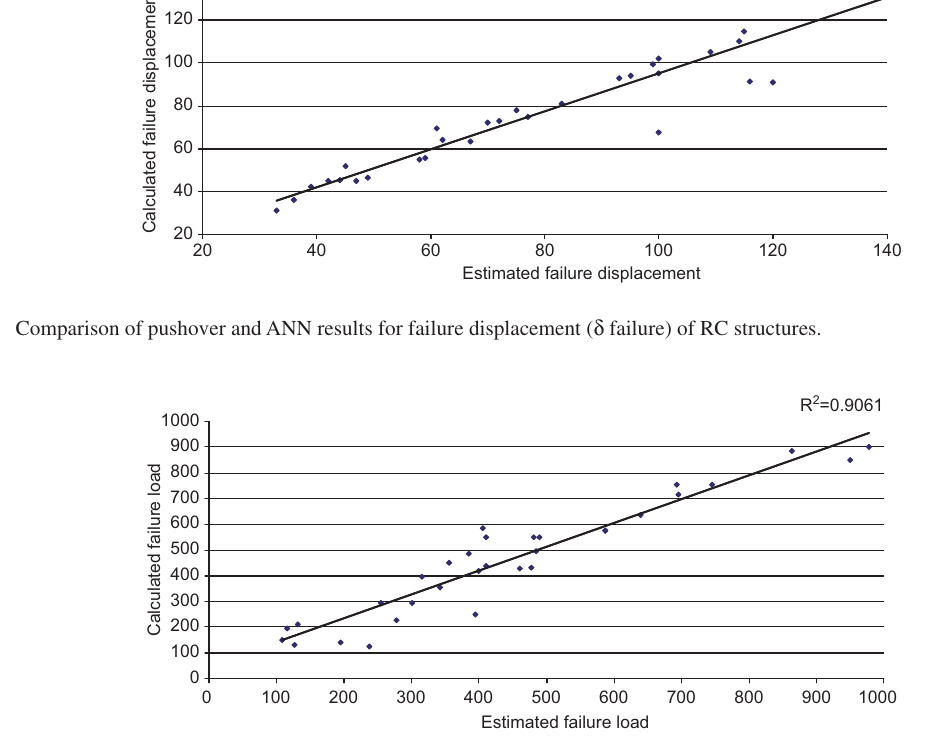
Figure 6 Comparison of pushover and ANN results for failure load (Vfailure) of RC structures. displacement values. Moreover, the R 2 value was found as 89.13 % for load